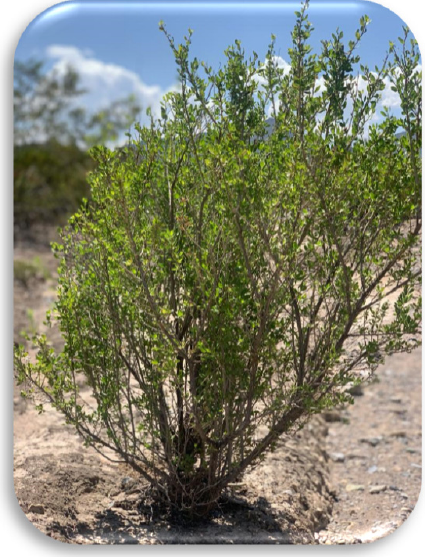
Figure 1. Flourensia cernua plant.